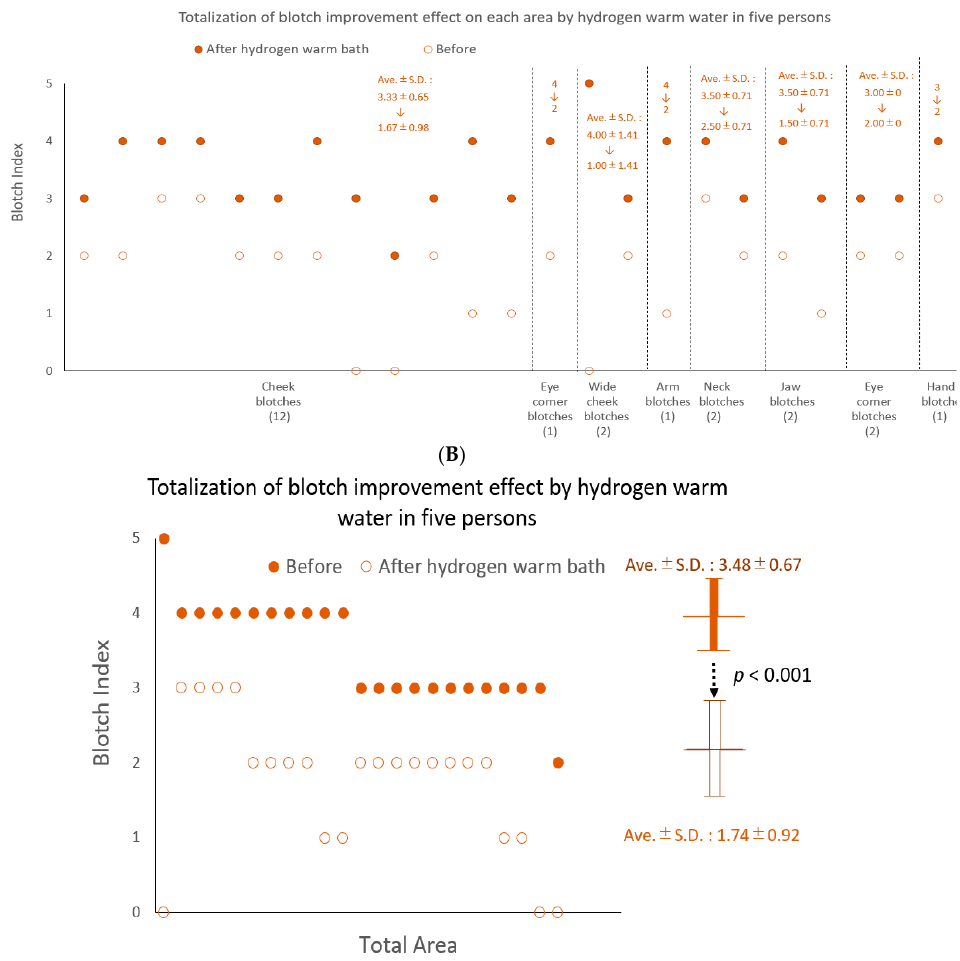
Figure 4. Effects of long-term daily usage of hydrogen rich warm bath and simultaneous affected-part poultice on blotches of the skin of face and hands. ( A ): Bar graph indicating change in the rank with five degrees before and after bathing, as divided by five subjects. Vertical axis shows the blotch index, while horizontal axis shows the numbering of analyzed are-as for each subject, as follows; 1: cheek blotch, 2: blotch of outer corner of the eye, 3: wide-ranged cheek blotch, 4: upper-outside-arm dispersed blotch (Right), 5: neck dispersed blotch, 6: jaw blotch, 7: eye-corner blotch, 8: hand blotch. ( B ): Dot graph indicating change in the rank with five degrees before and after bathing, as divided by each region of all subjects. ( C ): Dot graph indicating change in the rank with five degrees before and after bathing for total loci of all subjects. For Figure 4B,C, the mean values ± SD before and after treatment are described and analyzed by the Student’s t -test. * p < 0.05